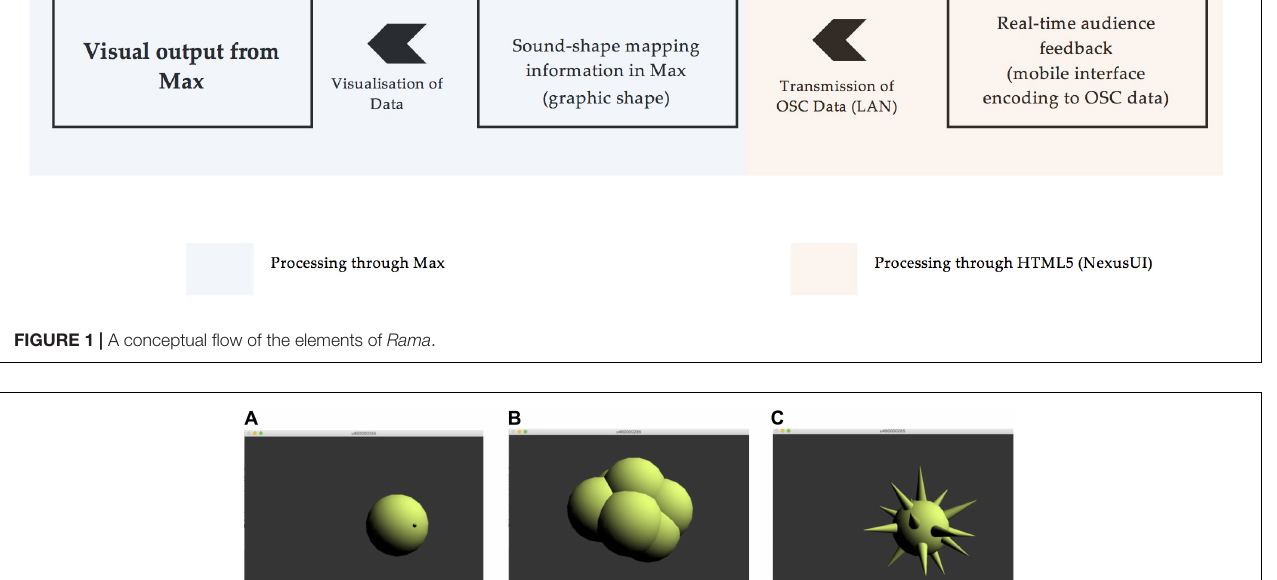
of the base sphere. The resultant shape of the object was therefore time-locked to specific points in time in the performance, allowing for a detailed quantification of an averaged shape within the